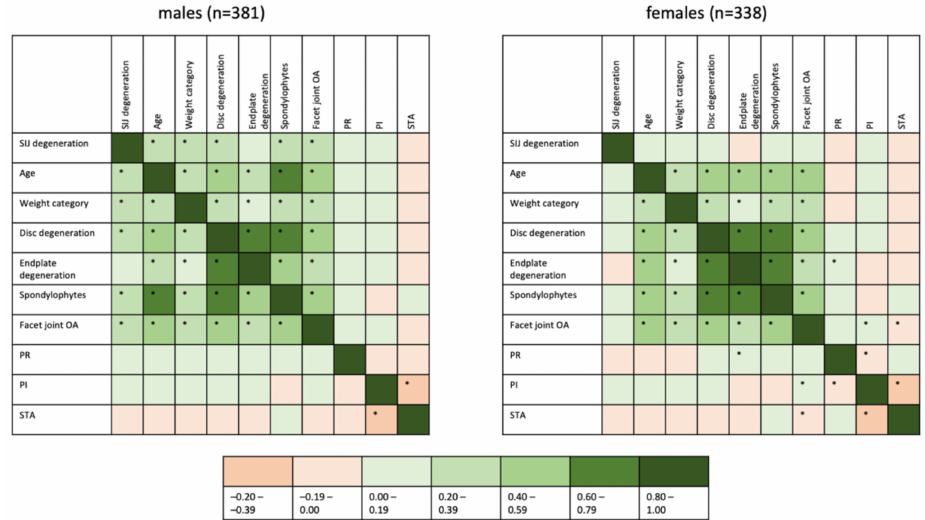
Figure 4. Heatmap of correlations between degeneration, clinical and anatomical factors. Correlation coefficients were derived from Kendall-tau-b analyses. Significant ( p < 0.001) correlations are marked with an asterisk within the box. As most associations were positive, an asymmetrical color scale was used for ease of